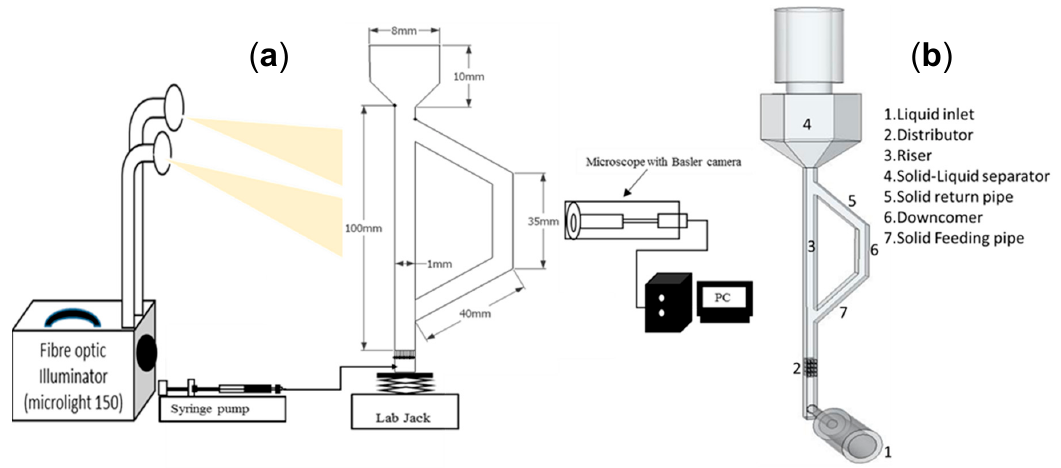
Figure 1. Schematic of ( a ) experimental set up for imaging and ( b ) micro circulating fluidised bed.